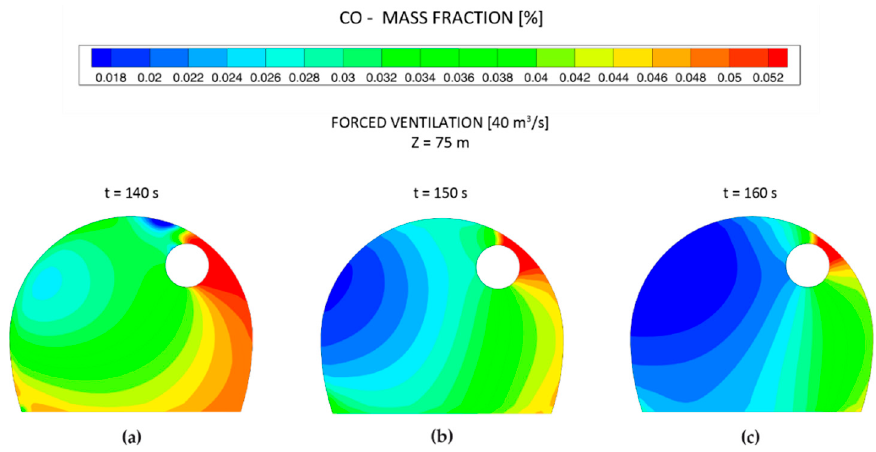
Figure 14. Distribution of the CO mass fraction at the cross section of Z = 75 m and different times, under forced ventilation and considering an airflow of 40 m 3 s − 1 .